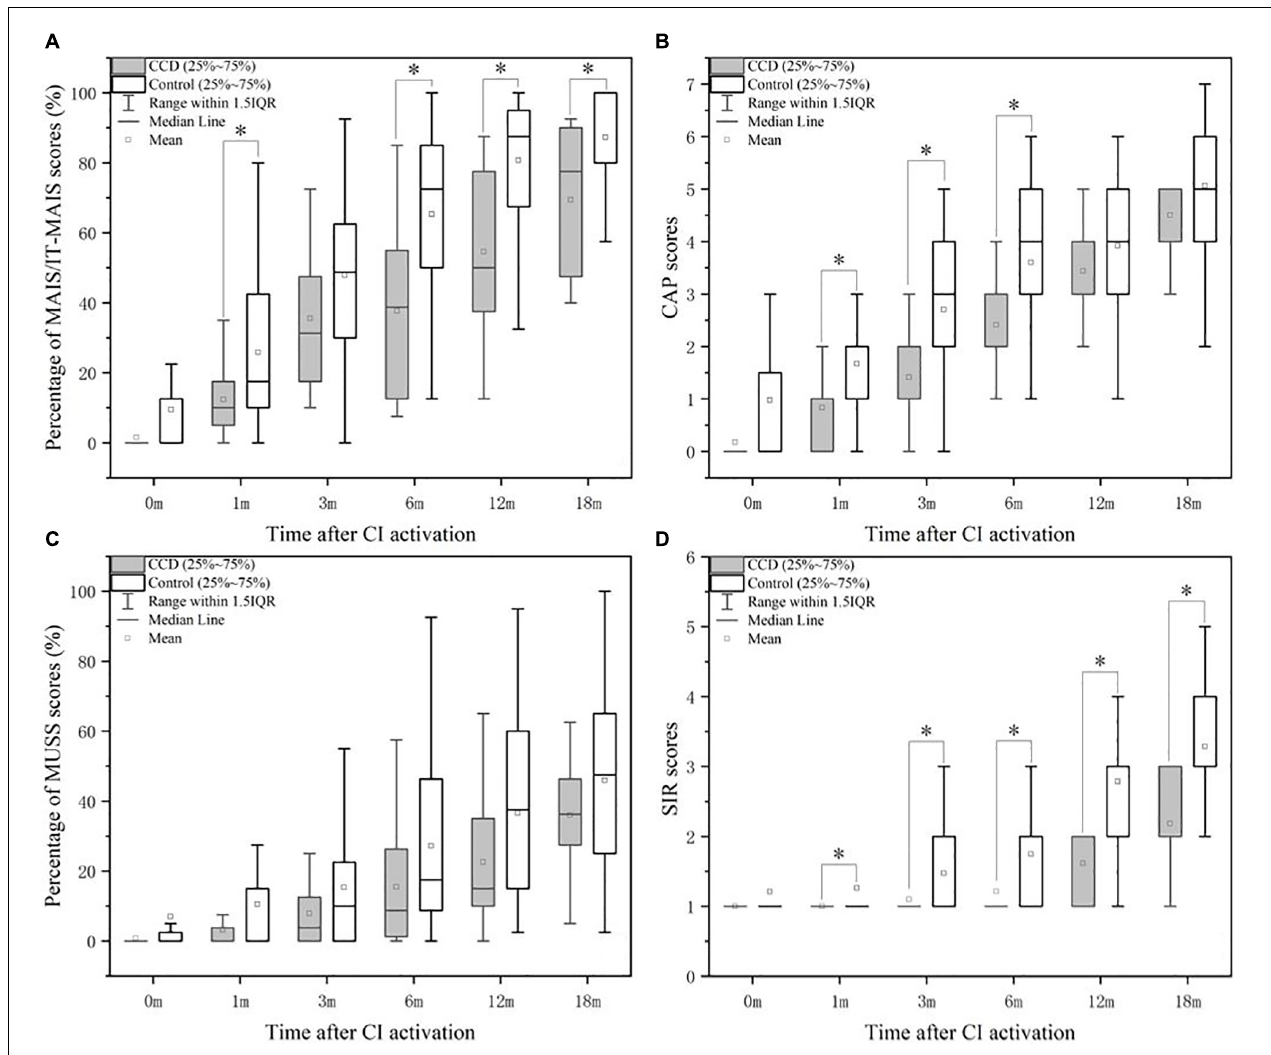
FIGURE 1 | Comparison of the performance in MAIS/IT-MAIS (A) , CAP (B) , MUSS (C) , and SIR (D) between the CCD and control groups. CAP, Categories of auditory performance; CCD, common cavity deformity; MAIS/IT-MAIS, Meaningful Auditory Integration Scale/Infant-Toddler Meaningful Auditory Integration Scale; MUSS, Meaningful Use of Speech Scale; SIR, Speech Intelligibility Rating. *indicates significant ( p <